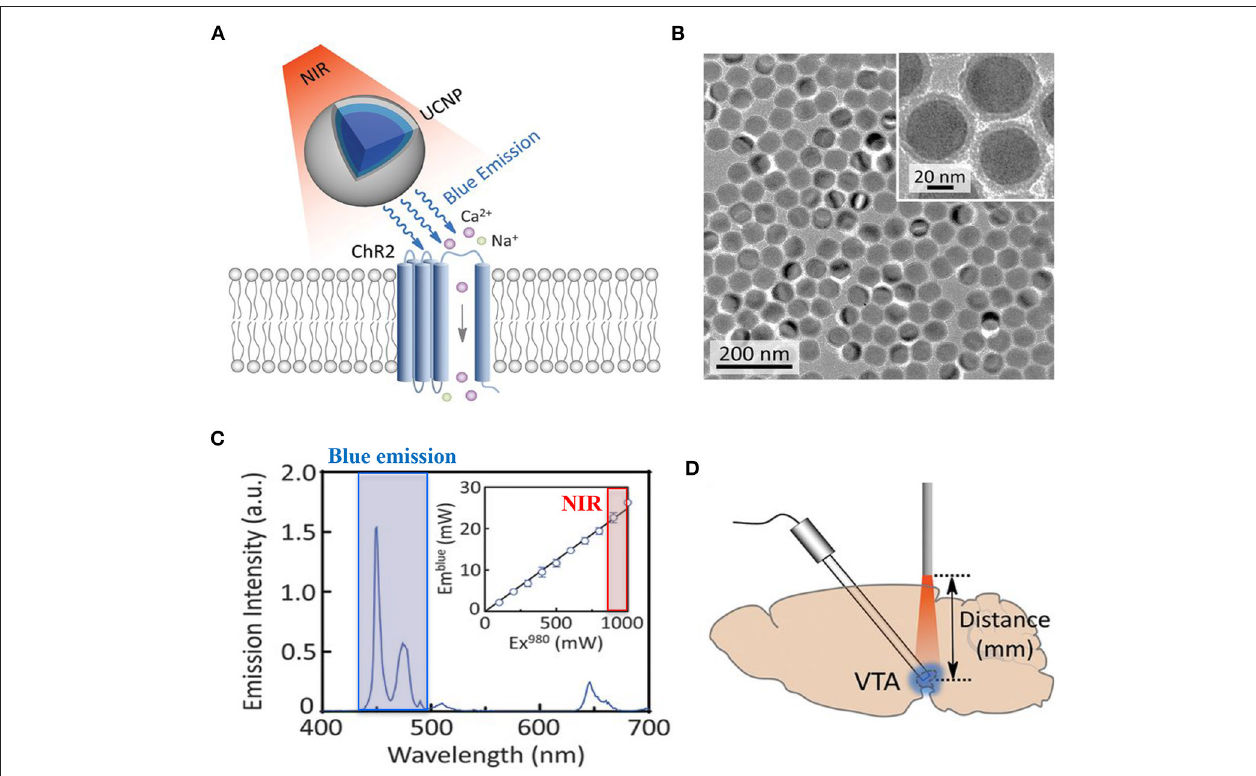
FIGURE 12 | UCNP-mediated NIR upconversion optogenetics for deep brain stimulation. (A) Schematic principle of UCNP-mediated NIR upconversion optogenetics. (B) Transmission electron microscopy images of the silica-coated UCNPs. (C) Emission spectrum of the nanoparticles upon excitation at 980nm. (Inset) Upconversion emission intensity of UCNPs as a function of excitation intensity at 980nm. (D) Scheme of in vivo fiber photometry for measuring UCNP-mediated NIR upconversion in deep brain tissue. The tip of an optic fiber, transmitting NIR excitation light, was positioned at various distances from the ventral tegmental area (VTA) where UCNPs were injected. Modified with permission from Chen et al.